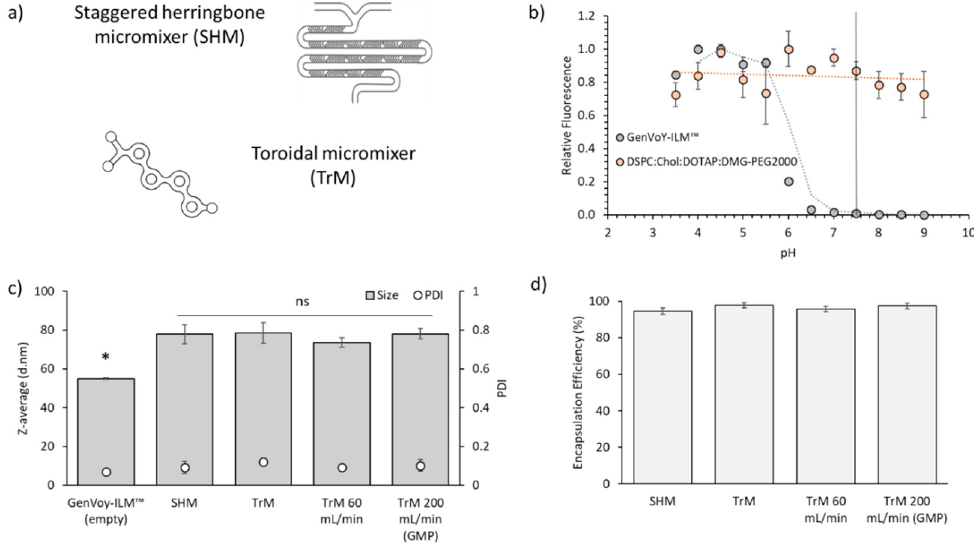
Figure 7. Scalable manufacture of iLNPs. ( a ) Schematic representation of the staggered herringbone micromixer (SHM) and toroidal mixer (TrM) used for the microfluidic production of LNPs. ( b ) Fluorescence titration curves of TNS with DSPC:Chol:DOTAP:DMG-PEG2000 cLNPs (orange circles) and GenVoy-ILM ™ iLNPs (grey circles) at various pHs for experimentally arriving at surface pKa values. ( c ) Particle size (bars) and PDI (open circles) and ( d ) PolyA encapsulation e ffi ciency of the LNPs (GenVoy-ILM ™ ; a proprietary lipid mix comprising DSPC:Chol:ionisable lipid:stabiliser, loaded with PolyA at di ff erent production speeds (from 12 to 200 mL / min). Results represent the mean of at least 3 independent batches and the standard deviation is plotted as error bars. Significant di ff erences are shown as * p < 0.05, and ‘ns’, when no statistical significance observed.